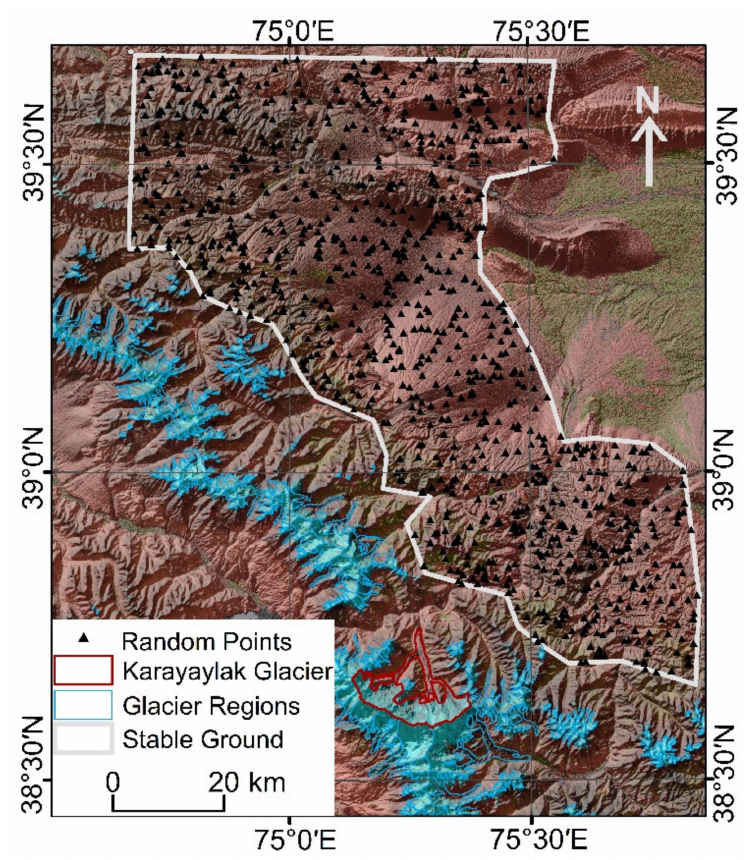
Figure 3. Overview of the stable ground around the Karayaylak glacier and 1000 random